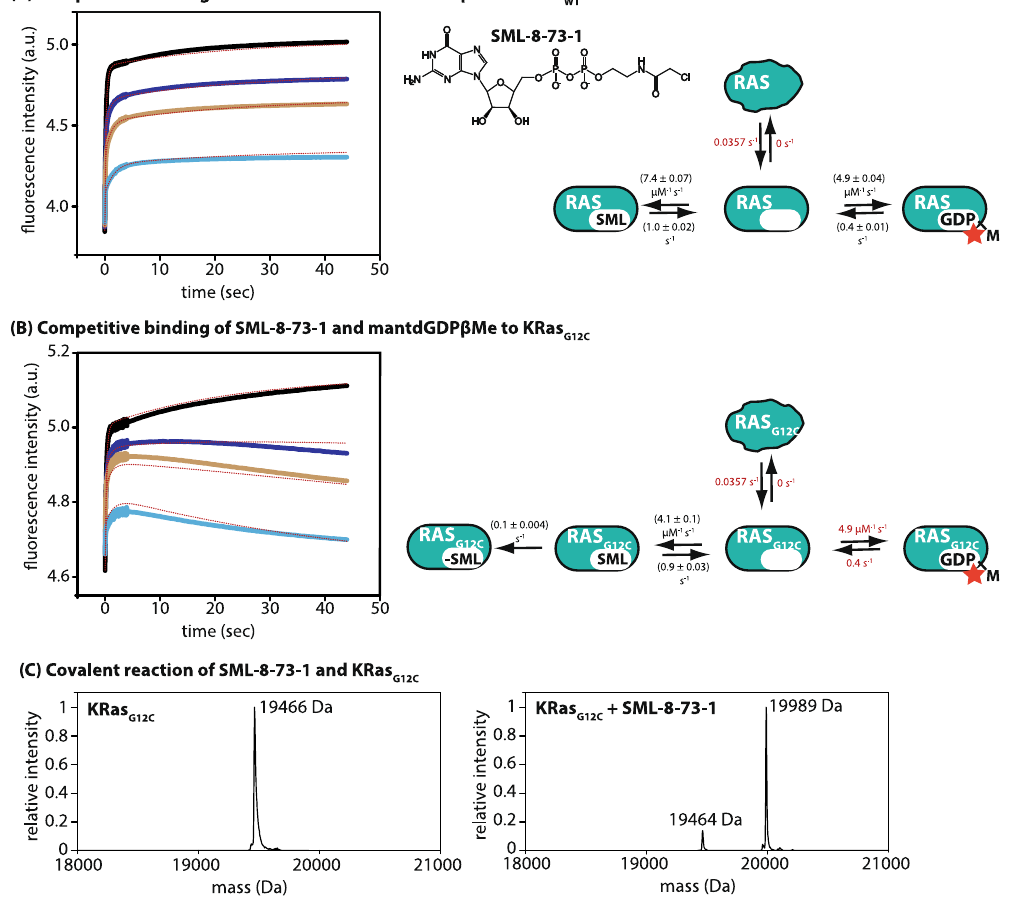
Figure 2. Reversible and irreversible interaction of the inhibitor SML-8-73-1 with KRas. ( A ) In order to quantify the reversible binding of SML-8-73-1, competition experiments of KRas WT binding to mantdGDP β Me in the absence (black curve) or in the presence of 0.5 µ M (blue), 1 µ M (orange) or 3 µ M (turquoise) SML-8-73-1 were performed and kinetic constants were obtained by global fitting of the data to the model on the right. ( B ) Irreversible binding was subsequently quantified by repeating the experiments from 2 A, but using KRas G12C instead of the wild type protein. The additional phase observed in these experiments in the presence of SML- 8-73-1 corresponding to displacement of initially bound mantdGDP β Me because of covalent reaction of the inhibitor allowed determination of the rate constant of covalent reaction of SML-8-73-1 with KRas G12C . ( C ) Covalent reaction was confirmed by mass spectrometry. The mass spectra of nucleotide-free KRas G12C before (left) and after (right) addition of SML-8-73-1 and quenching with 5 mM DTE after 20 s are